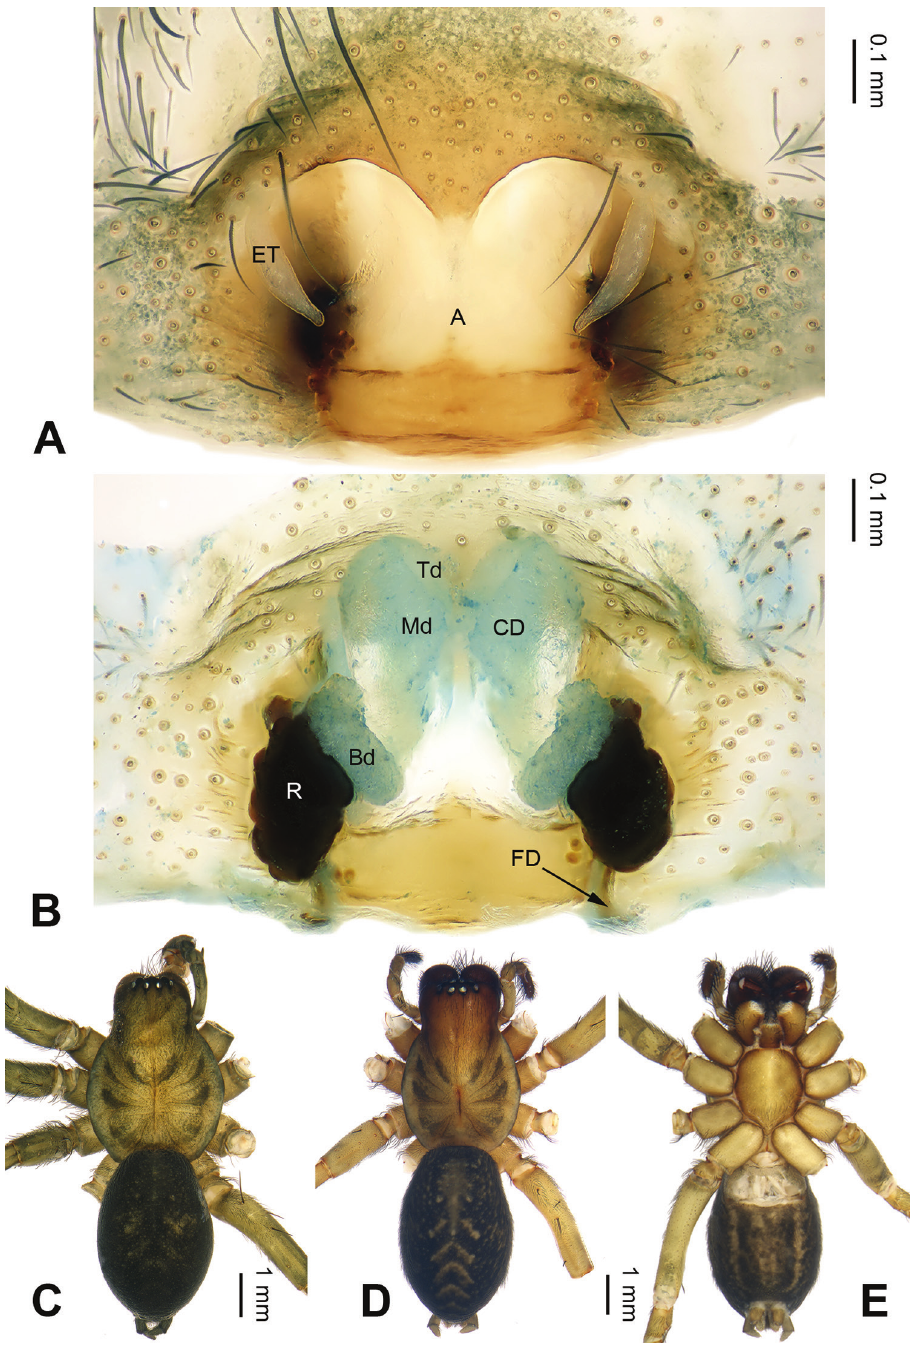
Figure 2. Pireneitega zonsteini sp. n., female paratype and male holotype. A Epigyne, ventral B Vulva, dorsal C Male habitus, dorsal D Female habitus, dorsal E Female habitus, ventral. Scale bars equal for D, E